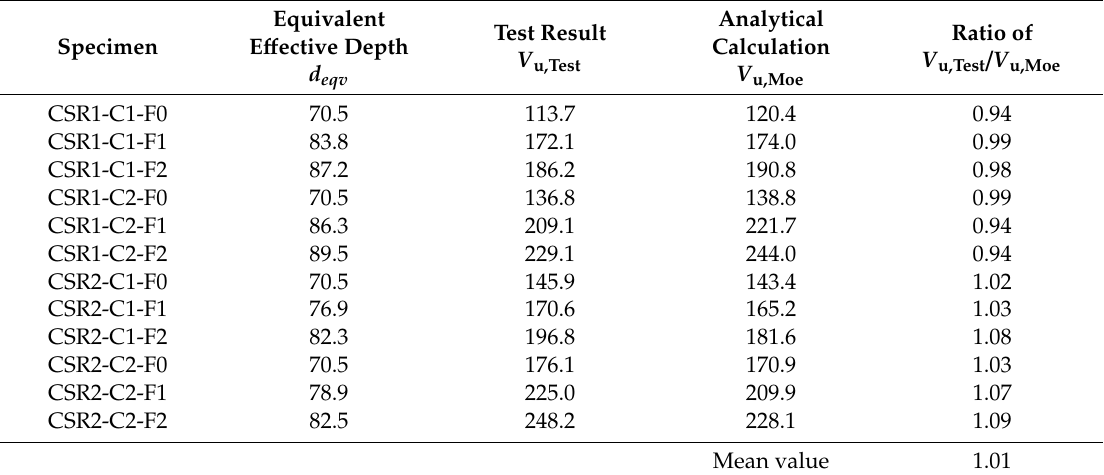
Table 4. Comparison between test results and analytical